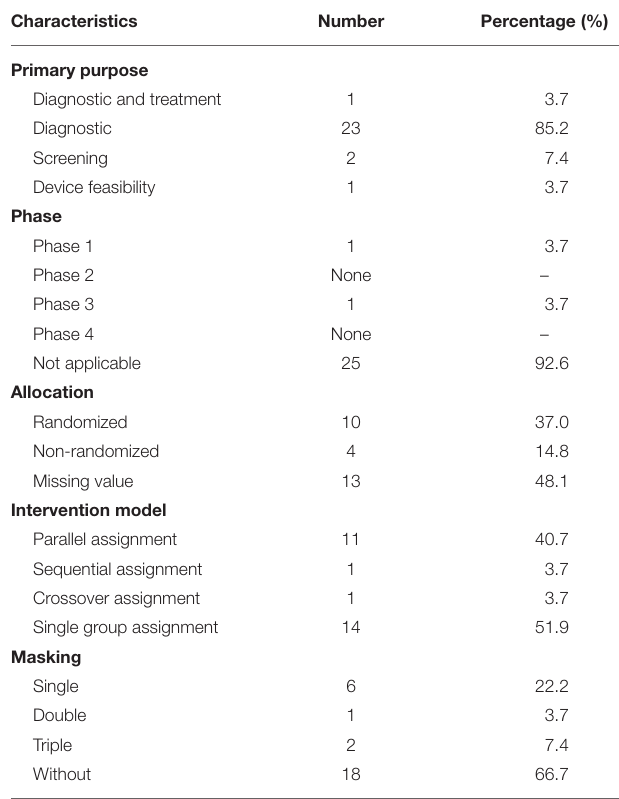
TABLE 1 | Characteristics of included trials. TABLE 2 | Study design elements of interventional trials.